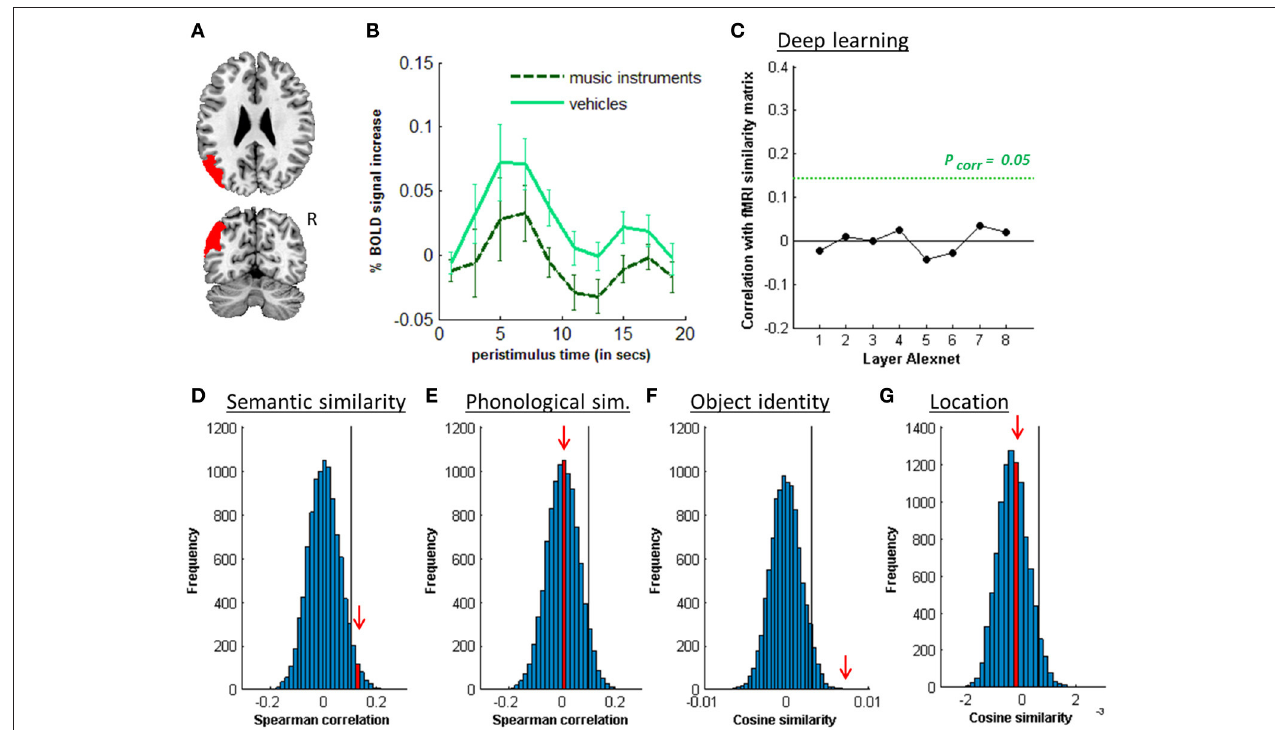
FIGURE 7 | MVPA effects in the left angular gyrus. (A) Axial (z = 26) and coronal (y = − 66) slice depicting posterior IPS. (B) Peristimulus response for musical instruments and vehicles. (C) Deep learning. Spearman correlation between the fMRI similarity matrix and the similarity matrices for the pictures for the eight layers of Alexnet. Statistical significance was evaluated by 10,000 random permutation labelings. The green dotted line corresponds to the statistical threshold corrected for the number of layers. (D) Probability distributions for the location-invariant semantic similarity effect. (E) Probability distributions for the phonological similarity effect. (F) Probability distributions for the location-invariant object identity effect. (G) Probability distributions for the object-invariant location effect. The red arrow indicates the true Spearman correlation/cosine similarity in the distribution of correlations/cosine similarities generated by 10,000 random permutations. X-axis: Spearman correlation averaged over the group of subjects. Y-axis: absolute frequency of a given average Spearman correlation value across all random permutation labelings. Black line: 95th percentile of the